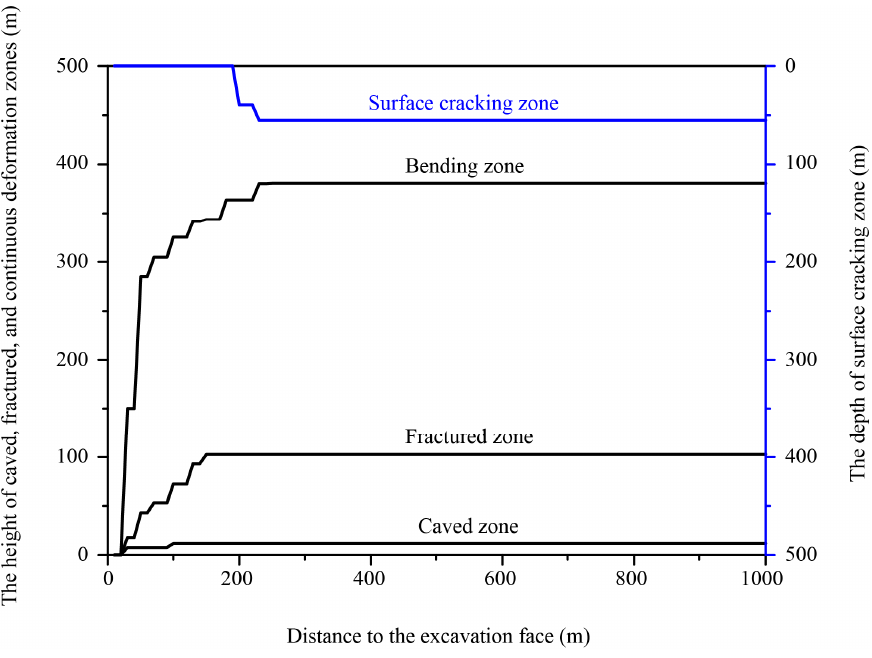
Figure 16. Relations between the advancing distance and the heights of the four zones.